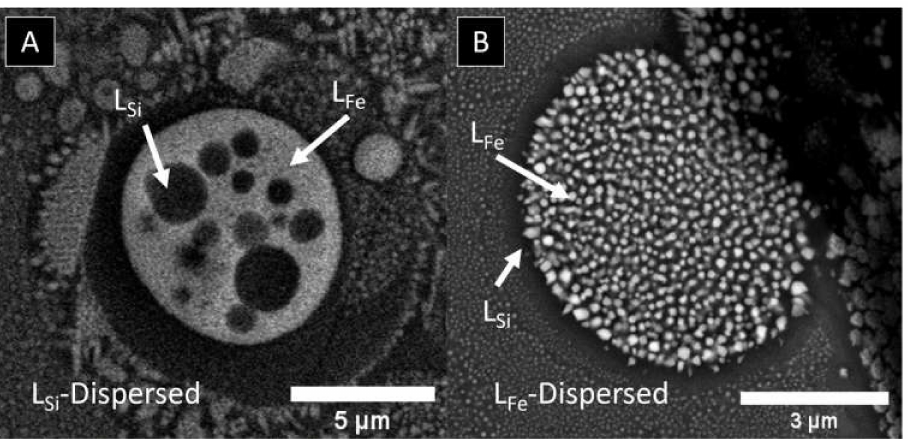
Figure 1. Backscatter electron images of typical amoeboids (( A )—L Si -dispersed, ( B )—L Fe -dispersed) observed in iron-rich fallout glasses. Bright regions represent Fe-rich regions (L Fe ), whereas darker regions are more Si-rich (L Si